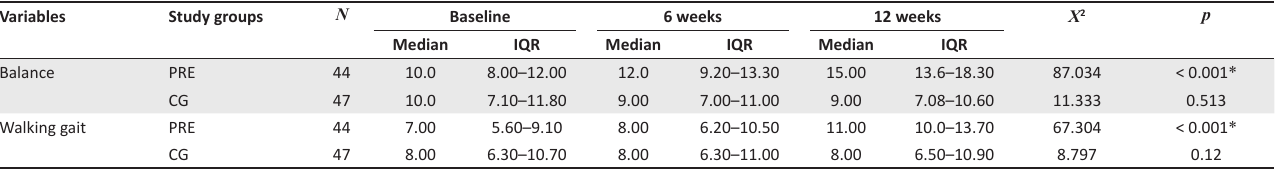
TABLE 2: Differences within groups in balance and gait scores across baseline, 6 weeks and 12 weeks.